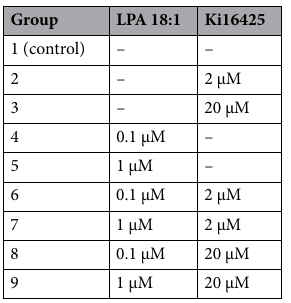
Table 1. Experimental